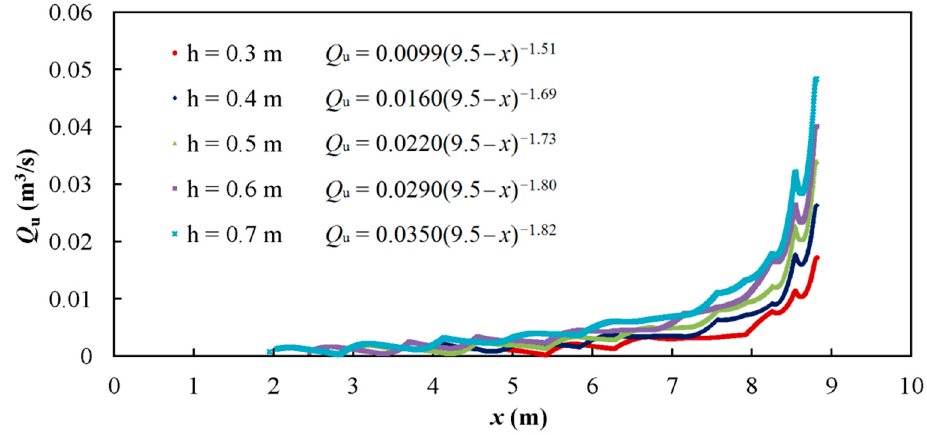
Figure 5. Relationship between the hyporheic flux ( Q u ) and the location along the stream ( x ) under the five modeling scenarios with different heights of the weir ( h ). Table 3. The coefficients of the regression equations for calculating the hyporheic flux ( Q u ) under the five modeling scenarios with different heights of the weir ( h ), and their R 2 values.